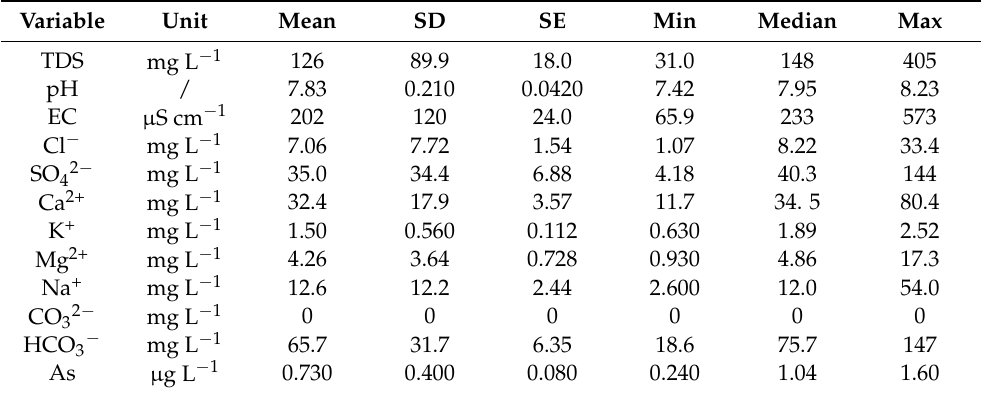
Table 2. Descriptive statistical analysis of river-water-chemistry variables in Altay Mts. region ( n = 25). Parameters include: mean value, standard deviation (SD), standard error of mean (SE), minimum (Min), median, and maximum (Max)